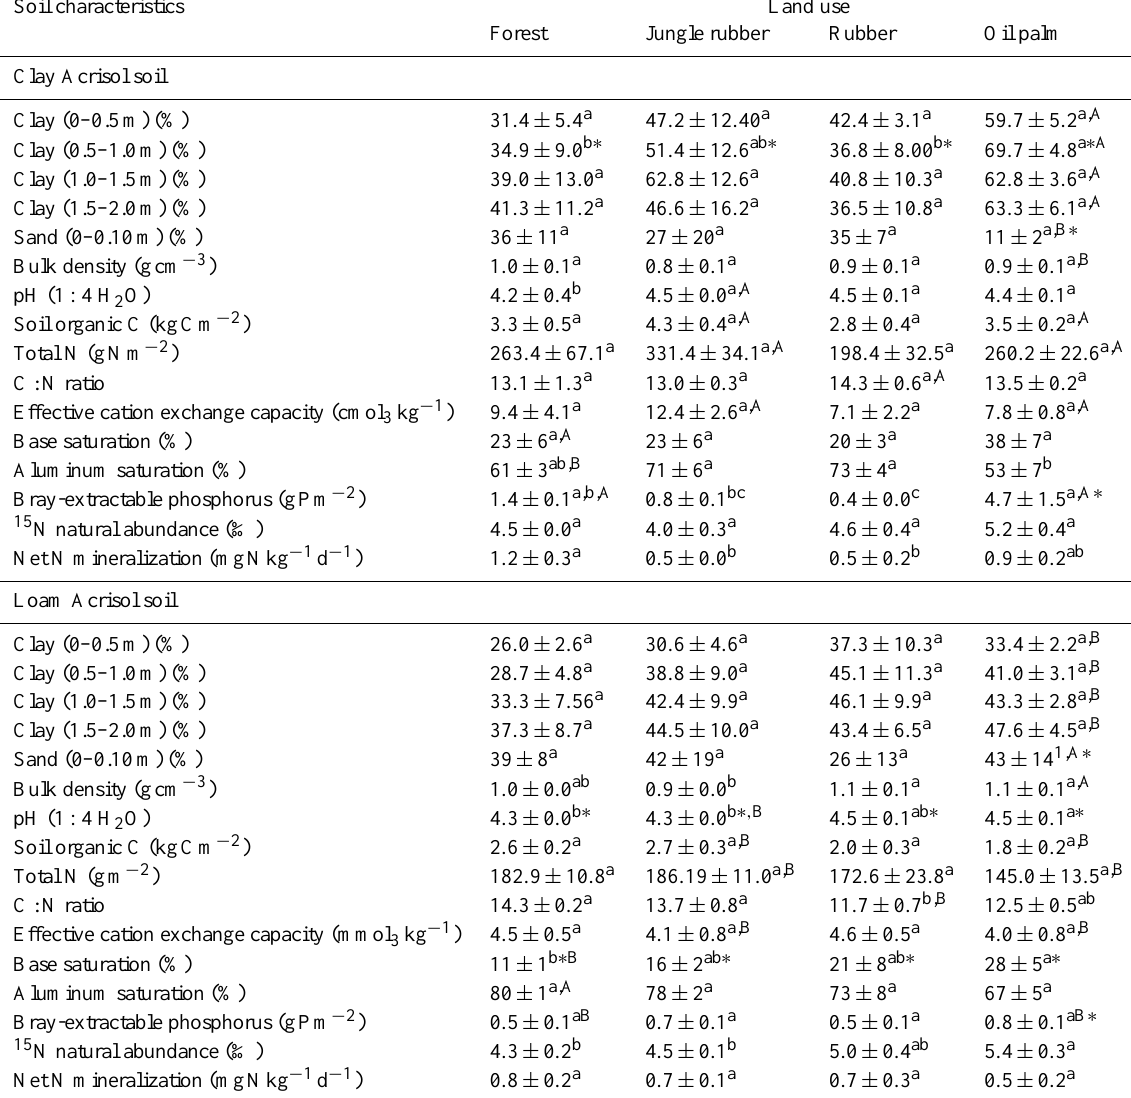
Table A1. Mean ( ± SE, n = 4) soil physical and biochemical characteristics in the top 0.10m depth (except for the clay content, 0–2m depth with n = 3) for different land-use types within each soil landscape in Jambi, Sumatra, Indonesia. Means followed by different lower- case letters indicate significant differences among land-use types within each soil landscape and different capital letters indicate significant differences between soil landscapes within a land-use type (linear mixed-effect models with Fisher’s LSD test at P ≤ 0 . 05 and marginally significant at ∗ P ≤ 0 . 09). Soil characteristics were measured by Allen et al. (unpublished data). Soil sampling and analysis are described in Appendix